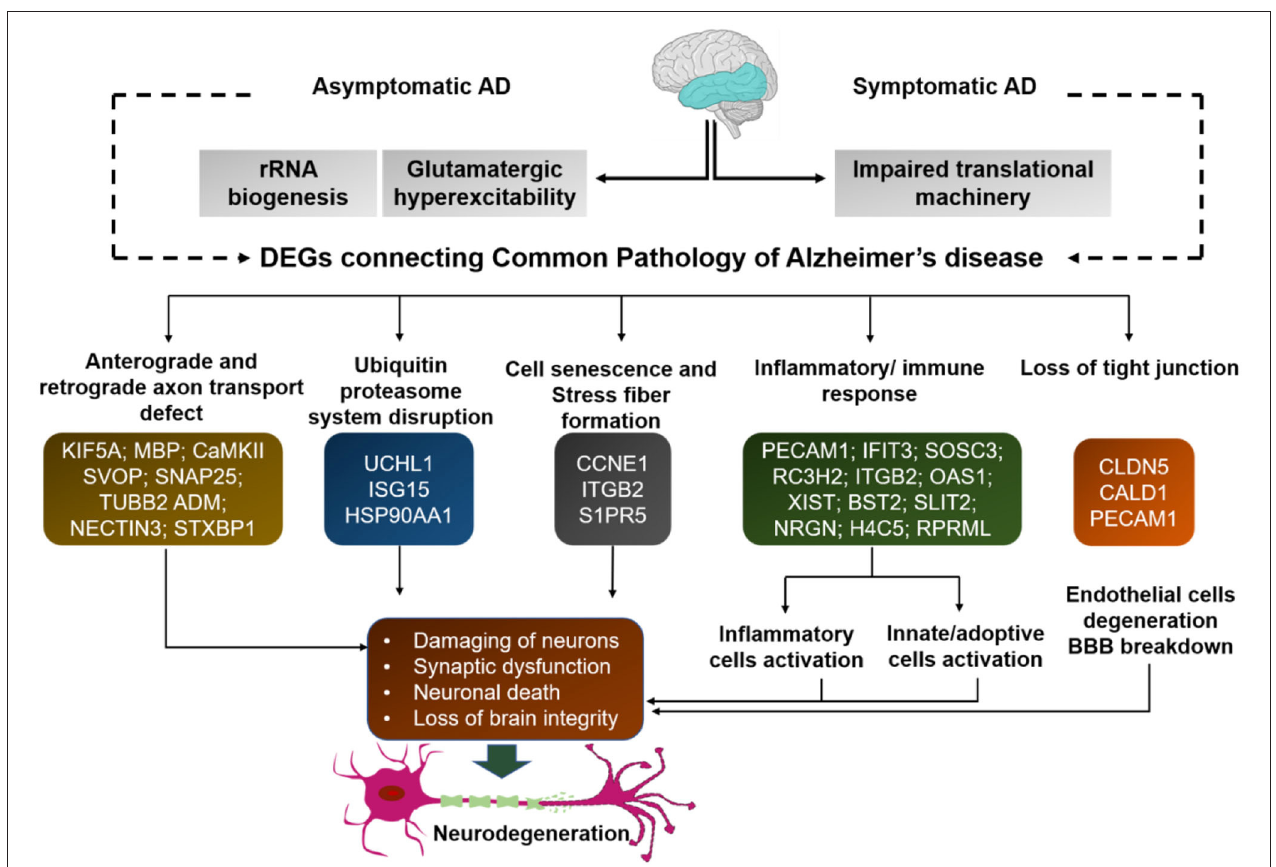
FIGURE 7 | Many of the differentially expressed genes from all comparison groups are associated with common signaling pathways. These genes differentially expressed in all comparison groups are associated with common signaling pathways. Thus, despite their differences, they have common functional connectivity in dysregulated mechanisms. Each gene from all comparison groups is shown in the respective boxes of different pathogenic